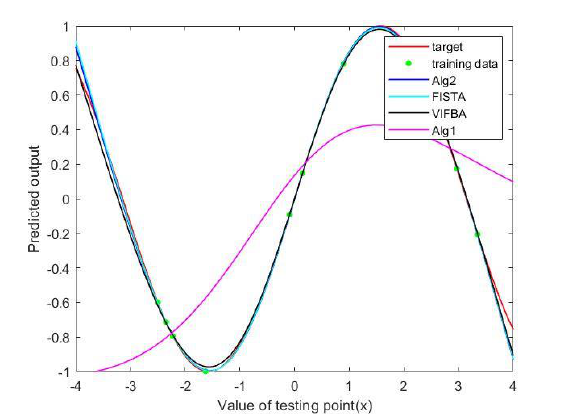
Figure 3. A regression of a sine function at the 3000th